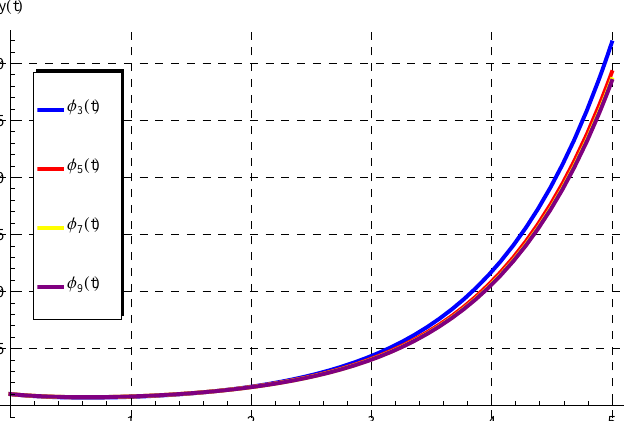
Figure 2. Plots of the approximate solutions φ m ( t ) , m = 3,5,7,9 in Equation (38) vs. t at λ = 1, c = 1 b = 1, and a = 2.